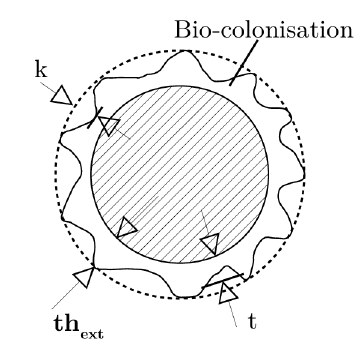
Figure 3. Definition of thickness ( t ) commonly used in standards vs. Practical measurement of thickness ( th ext ) on-site.